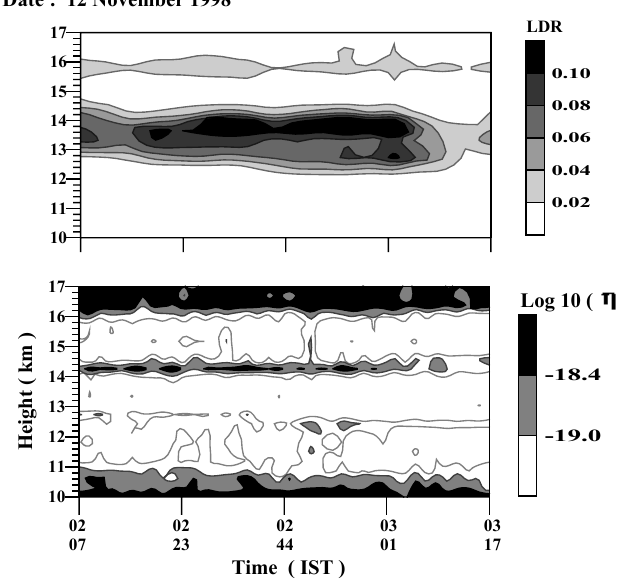
Fig. 3. Range-Time plot of radar reflectivity and lidar LDR during the passage of cirrus on 12 November 1998 (Case 1). The X-axis represents the time scale in hrs,